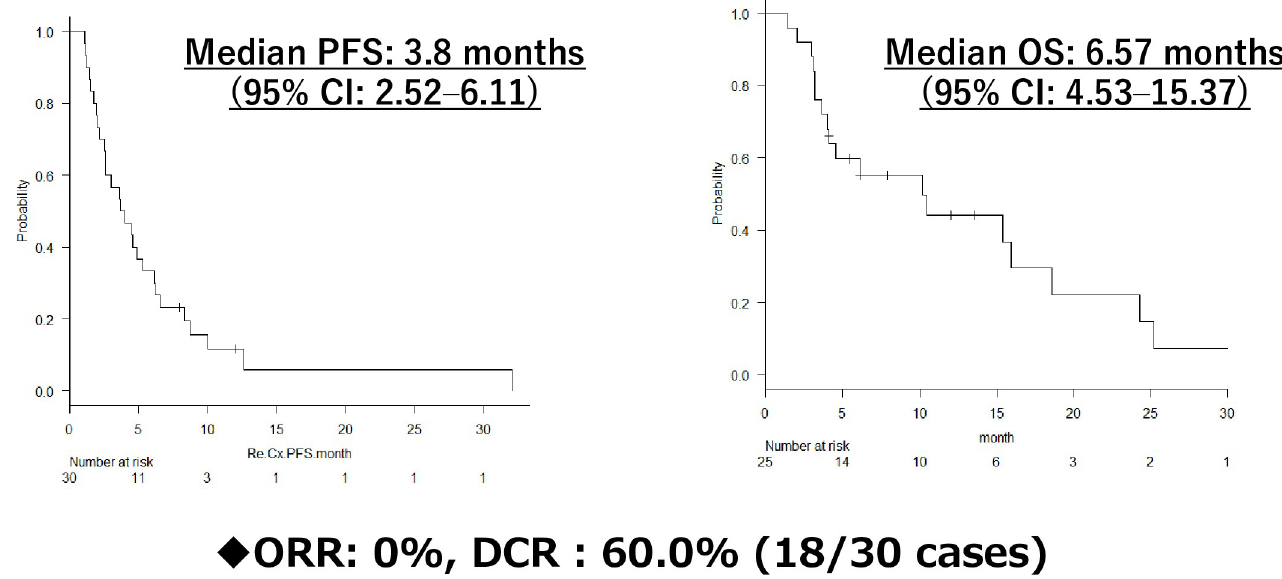
Fig 1. PFS, OS, ORR, and DCR of Re-Cx for 30